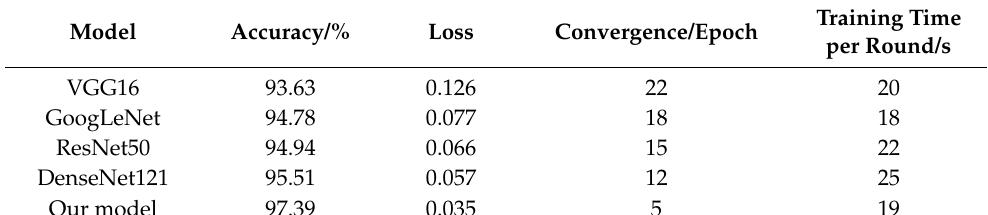
Table 4. Comparison of the experimental results of various models.